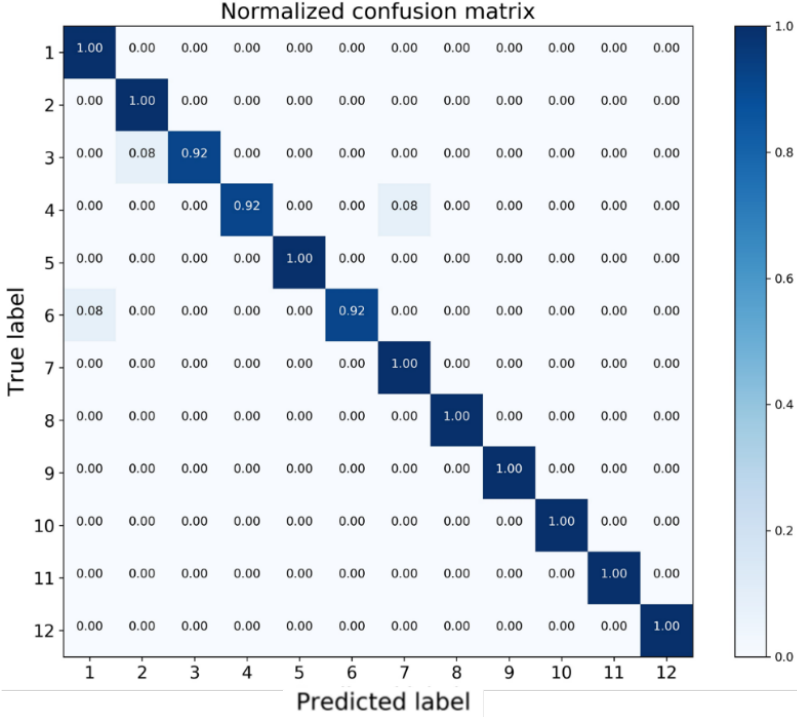
Figure 9. Confusion matrix of flight state identification.